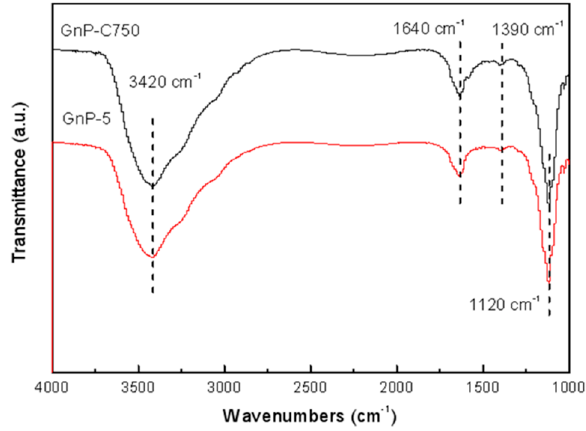
Figure 3. FTIR spectra of GnP-C750 and GnP-5.